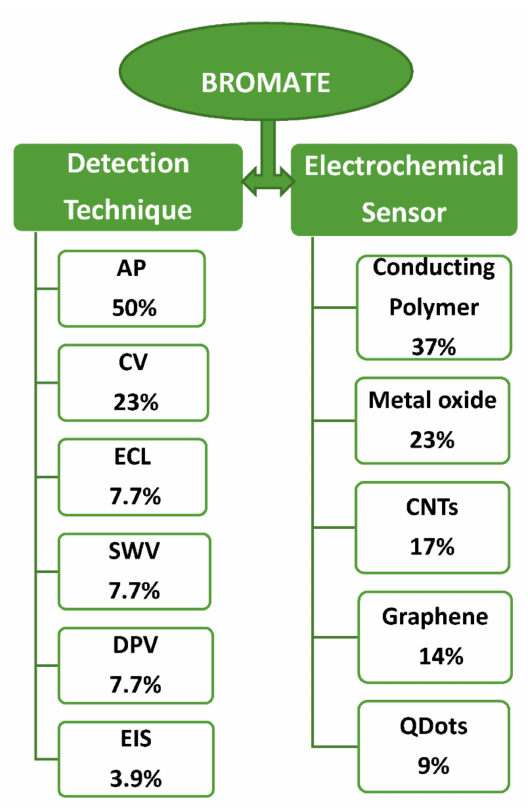
Figure 6. Summary of the electrochemical techniques and sensors for bromate